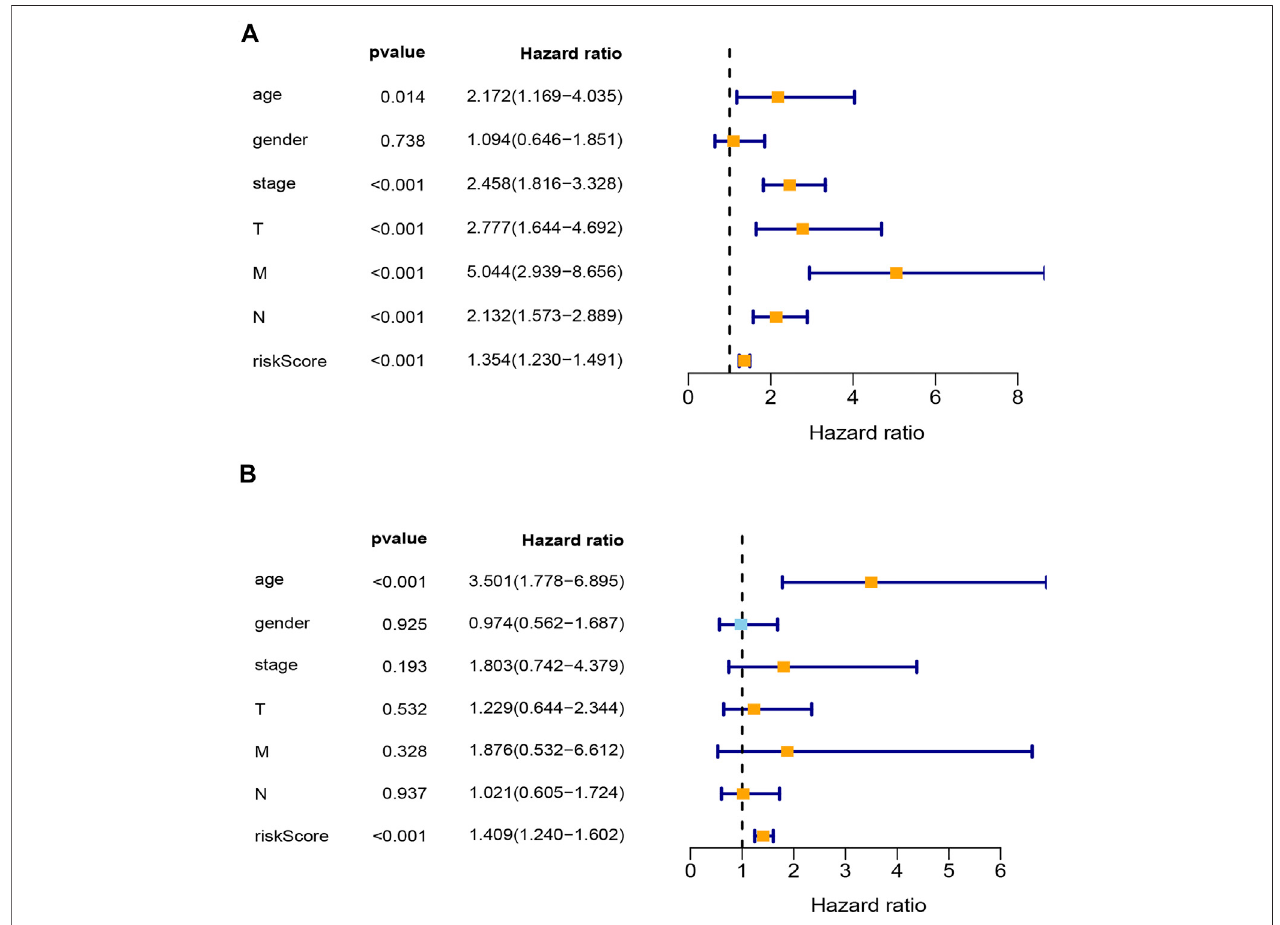
FIGURE 4 | Analysis of clinical independence for riskScore. (A) Univariable Cox regression analysis for clinical characters and risk score. (B) Multivariable Cox regression analysis for clinical characters and risk score. T, T stage; N, N stage; M, M stage; stage, TNM stage; riskScore, risk score model.